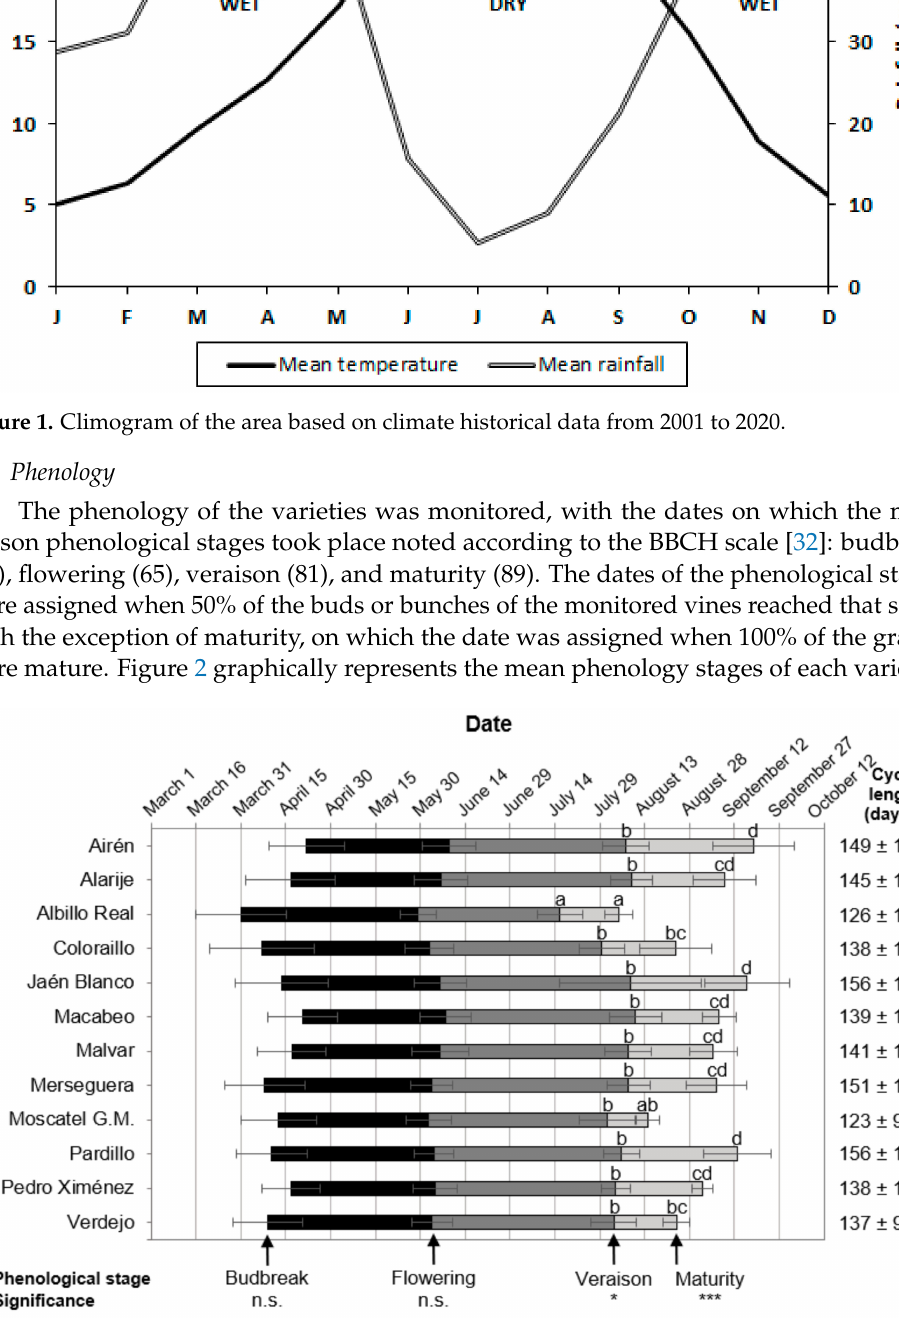
Figure 2. Length and date of each phenological stage in the different varieties. Bars are three- year means, and error bars are standard deviations. Different colored bars indicate the length of each period between phenological stages. Cycle length shows mean value ± standard deviation. Different letters indicate statistical differences among varieties by Duncan test (ANOVA; *, p < 0.05; ***, p < 0.001; n.s., not